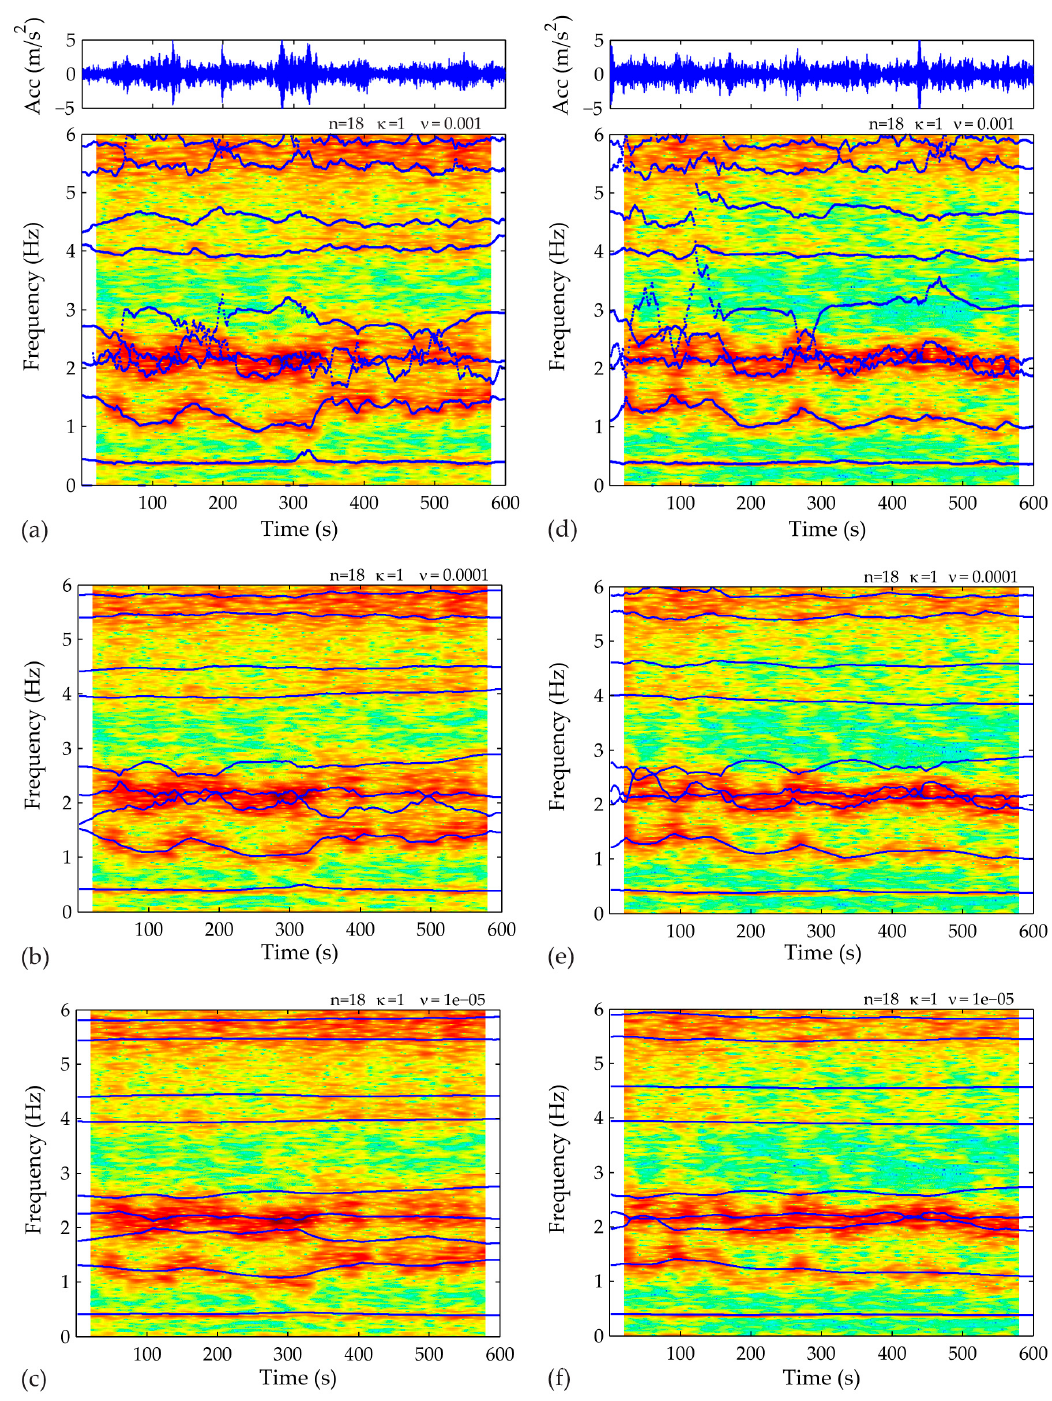
Figure 10. SP-TARMA (n = 18, k = 1) model tuning for Case B by varying the value of the ratio of model residuals. First sample of a 10-min acceleration signal fitted with: ( a ) ν = 0.001; ( b ) ν = 0.0001; ( c ) ν = 0.00001; Second sample of a 10-min acceleration signal fitted with: ( d ) ν = 0.001; ( e ) ν = 0.0001; ( f ) ν = 0.00001.